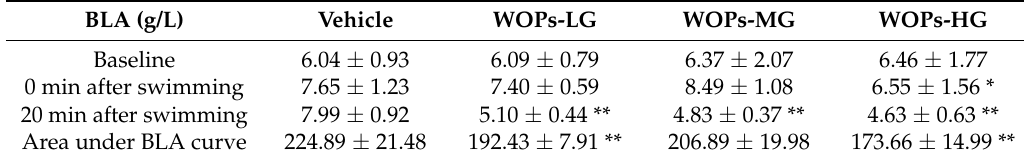
Table 2. Effects of WOPs on the level of BLA at different time points in mice.